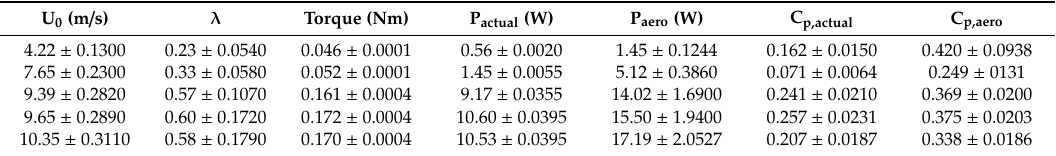
Table 4. Calculated actual power, aerodynamic power and power coe ffi cients.